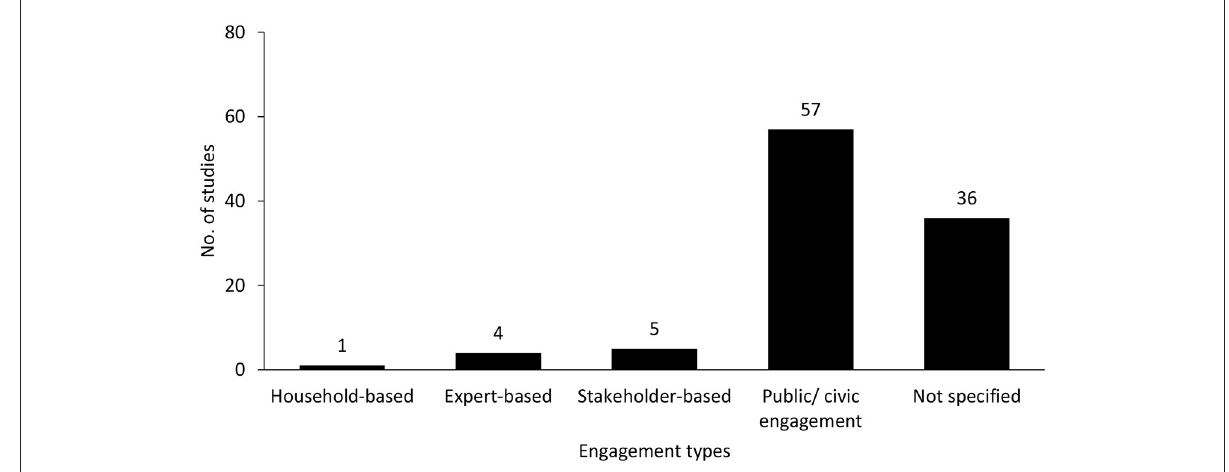
FIGURE4 Engagement typologies and their frequencies as specified in the selected studies analyzed (total n = 104 studies).